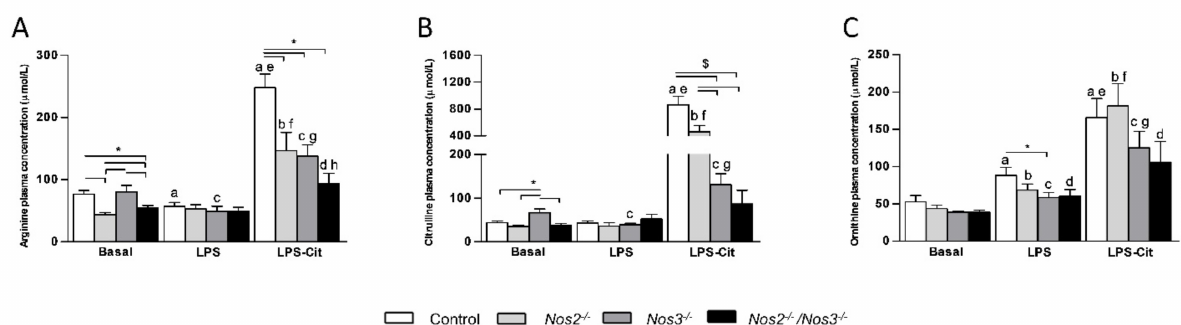
Figure 1. Plasma arginine, citrulline and ornithine concentrations in control and Nos -deficient mice under basal and endotoxemic conditions with or without L-citrulline supplementation. ( A ) Plasma arginine concentrations in control and Nos -deficient mice under basal and endotoxemic conditions with or without L-citrulline supplementation. ( B ) Plasma citrulline concentrations in control and Nos -deficient mice under basal and endotoxemic conditions with or without L-citrulline supplementation. ( C ) Plasma ornithine concentrations in control and Nos -deficient mice under basal and endotoxemic conditions with or without L-citrulline supplementation.* p -value < 0.05; $ p -value < 0.001; a p -value < 0.05 vs. control mice under basal conditions; b p -value < 0.05 vs. Nos2 − / − mice under basal conditions; c p -value < 0.05 vs. Nos3 − / − mice under basal conditions; d p -value < 0.05 vs. Nos2 − / − /Nos3 − / − mice under basal conditions; e p -value < 0.05 vs. control + LPS; f p -value < 0.05 vs. Nos2 − / − mice + LPS; g p -value < 0.05 vs. Nos3 − / − mice + LPS; h p -value < 0.05 vs. Nos2 − / − /Nos3 − / − mice + LPS. Data are shown as mean ± SEM. Statistical significance was determined with one-way ANOVA and post-hoc Bonferroni correction between groups.